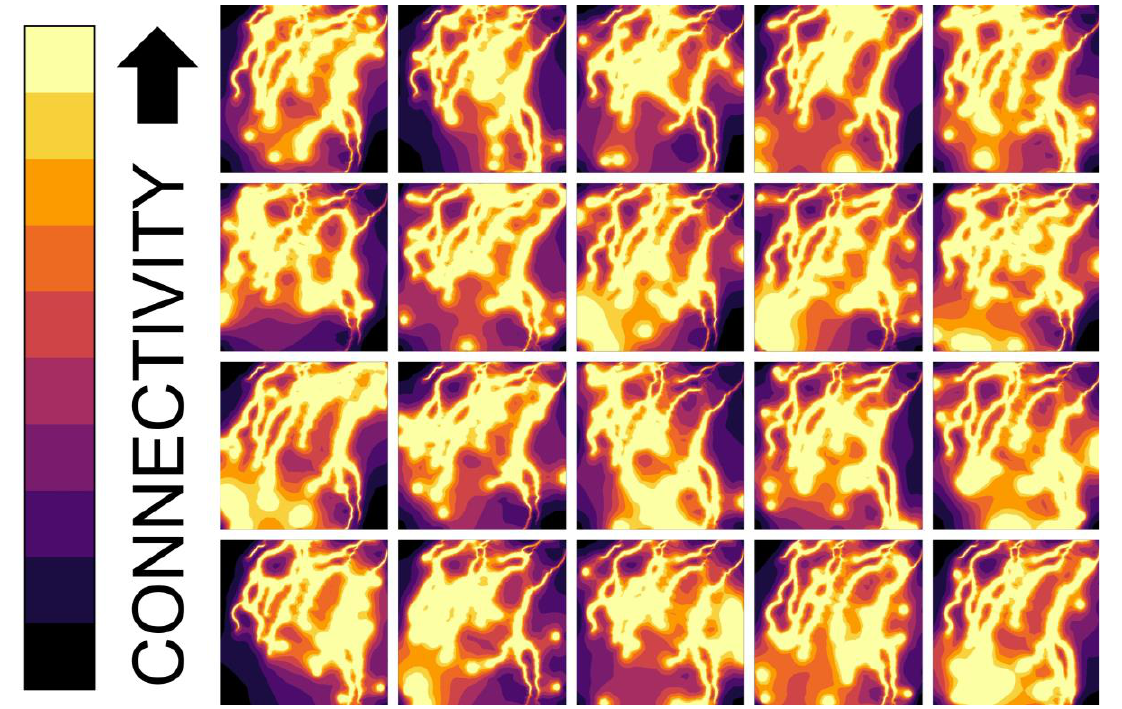
Figure 2. Electrical current outputs from 20 randomized start locations using Circuitscape in Julia [56]. Panes depict relative landscape connectivity based on landscape resistance dictated by the distance from the nearest water source. Elevation and slope were tested as potential modifiers of resistance but added little to understanding landscape resistance across the Pumice Plain versus the simpler landscape resistance with distance from water. The size and extent of the geospatial area in this figure are the same as those for Figure 1, Pane C. Projection: WGS 84/UTM Zone 10N. Figure created in ArcGIS Pro (version 3.0.0) [92].